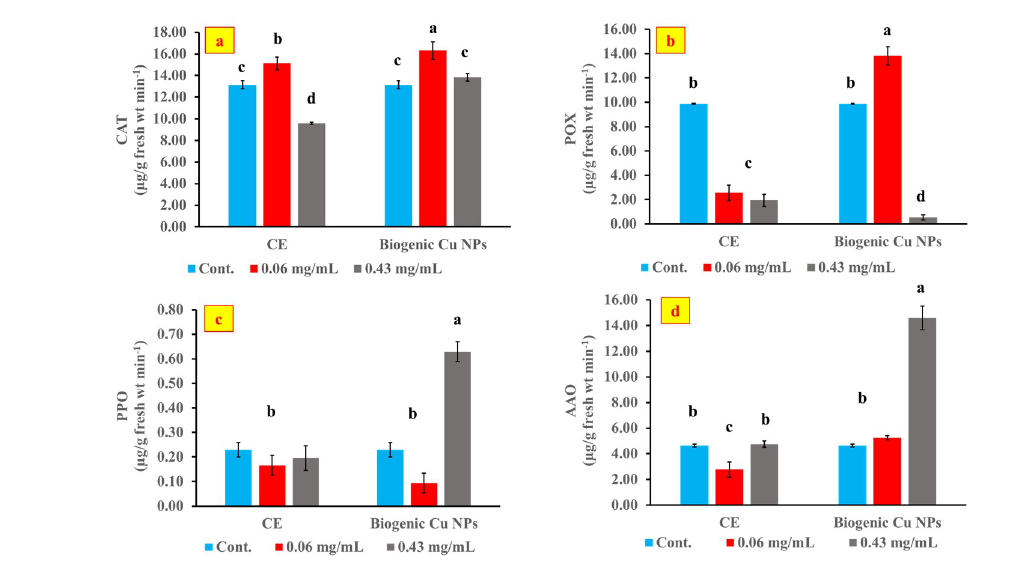
Fig 7. Effect of CE and Cu NPs on CAT (a), POX (b), PPO (c) and AAO (d) activities in wheat germinated seeds ( μ g/g fresh wt min -1 ) at the 4 th day of